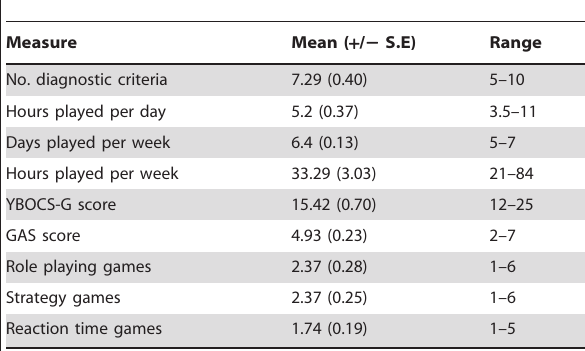
Table 1. Videogame-playing